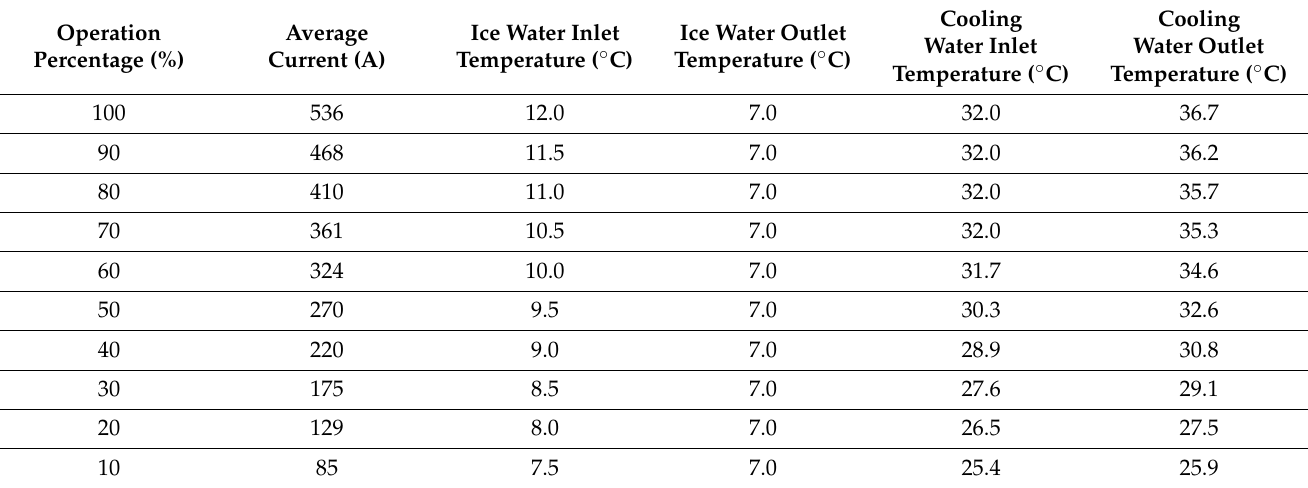
Table 6. Commercial consumer code program operation mode output of water chiller.